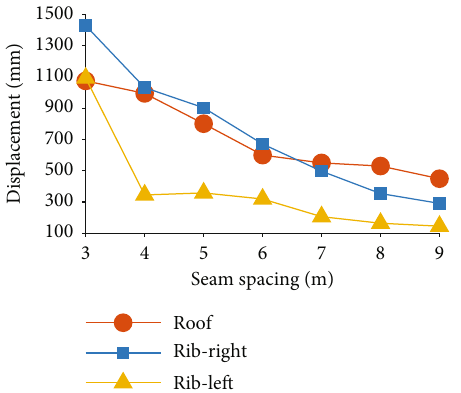
Figure 12: Simulation displacement of surrounding rock of the entry for di ff erent seam